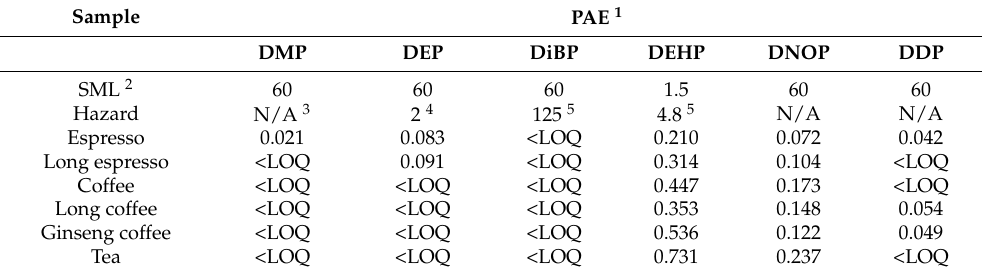
Table 9. PAEs concentration levels ( µ g mL − 1 ) determined in samples withdrawn by vending